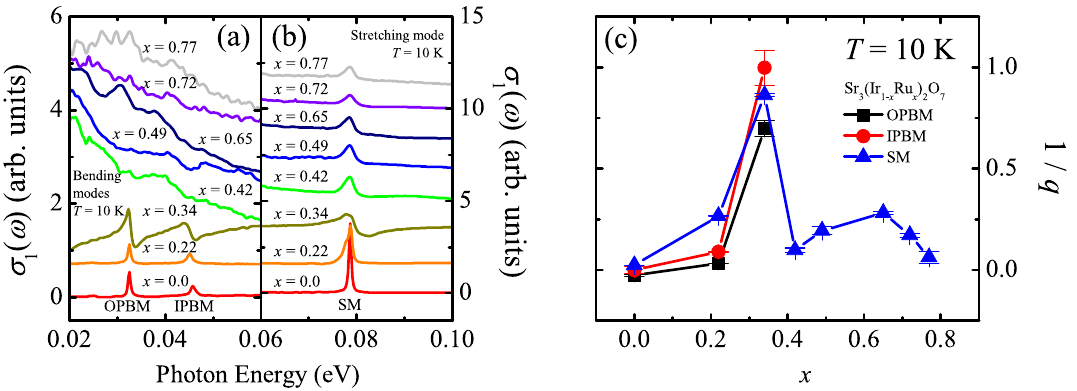
Figure 5. Low-energy σ 1 ( ω ) of Sr 3 (Ir 1- x Ru x ) 2 O 7 at 10 K. ( a ) The out-of-plane bending mode (OPBM) at 33 meV and the in-plane bending mode (IPBM) at 45 meV are shown. ( b ) The stretching mode (SM) at 78 meV is shown. The baseline of each spectrum is shifted for clarity. ( c ) Doping dependence of the inverse of the Fano parameter, i.e., 1/ q